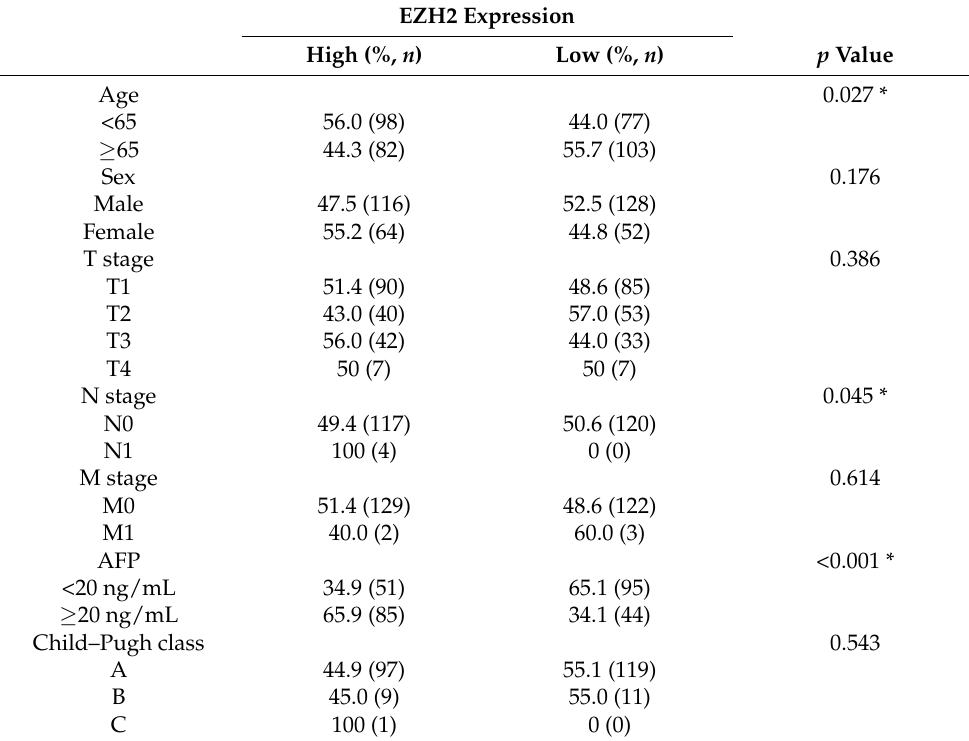
Table 3. Clinical characteristics of EZH2 expression in hepatocellular